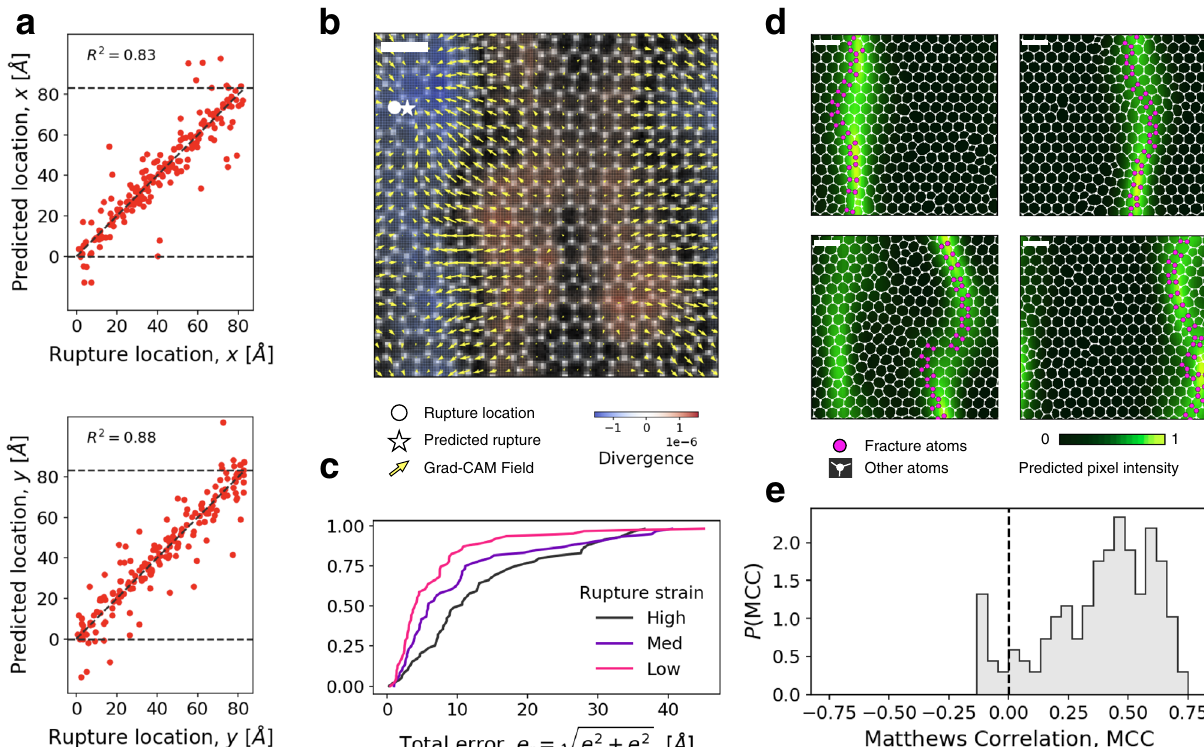
Fig. 5 Machine learning predicts rupture locations. a ResNet prediction matches the true rupture location on x and y coordinate (top and bottom panels respectively) in stretched silica glass samples. Rupture location is de fi ned as the location of the fi rst breaking bond. b Grad-CAM attention fi eld G x , G y obtained from the two models shown in panel A: the fi rst component of the vectors G x represents the Grad-CAM attention value for the x prediction, whereas the second is the value G y corresponds to the y prediction. The overlapped colormap reports the divergence of the fi eld, from negative (blue) to positive (red) values. The circle indicates the true rupture location of the sample, while the star marks the predicted one. c Cumulative distribution of the total location error e r for the three different rupture strain levels de fi ned in Fig. 4e. d Examples of full crack path prediction. The predicted pixel intensity is shown as a black to green shaded background. The unstretched silica is overlayed in white and the atoms involved in the actual crack path are colored in bright magenta. e Distribution of the Matthews correlation coef fi cient (MCC) across the entire test set. The scalebar of the images of silica is 10 Å